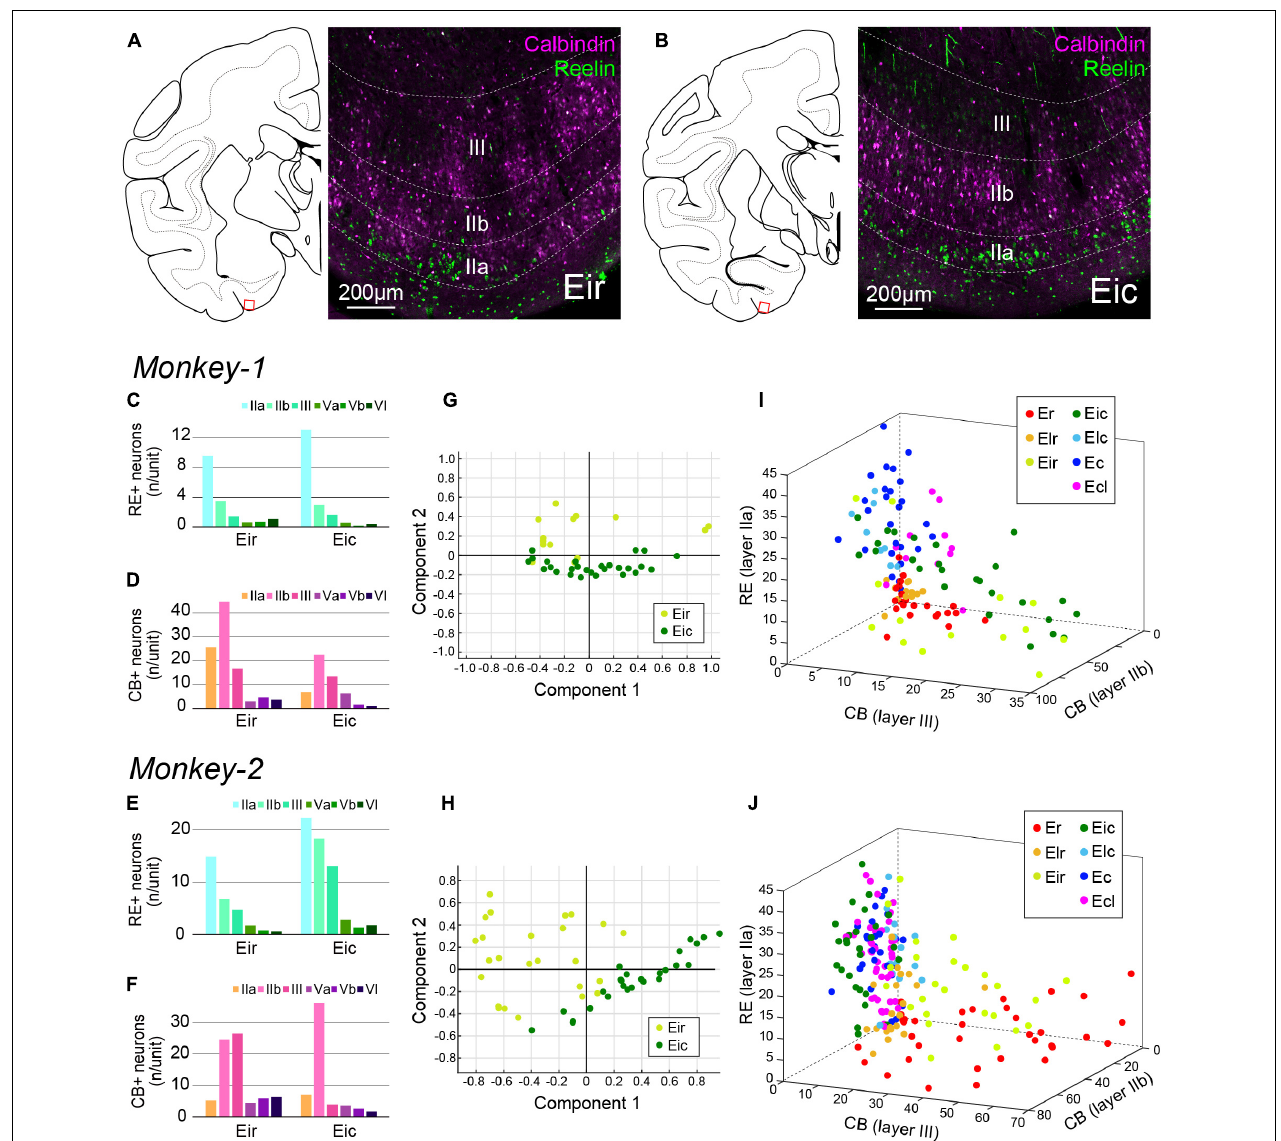
FIGURE 7 | Parcellation of Ei based on CB + and RE + neurons. (A,B) Fluorescent micrographs of CB + neurons (magenta) and RE + neurons (green) in Eir (A) and Eic (B) . For both images, the position is indicated as the squared area in the schematic line drawing of the coronal section to the left. (C–F) A diagram showing the number/unit of either RE + neurons (C,E) or CB + neurons (D,F) in Eir and Eic across layers. (G,H) Principal component analysis for Monkey-1 (G) and Monkey-2 (H) based on the parameters shown in (C–F) . (I,J) Separation of EC subdivisions using number/unit of CB + neurons in layer IIa, and layer III, and the number of RE + neurons in layer IIa as distinction criteria, in Monkey-1 (I) and Monkey-2 (J)